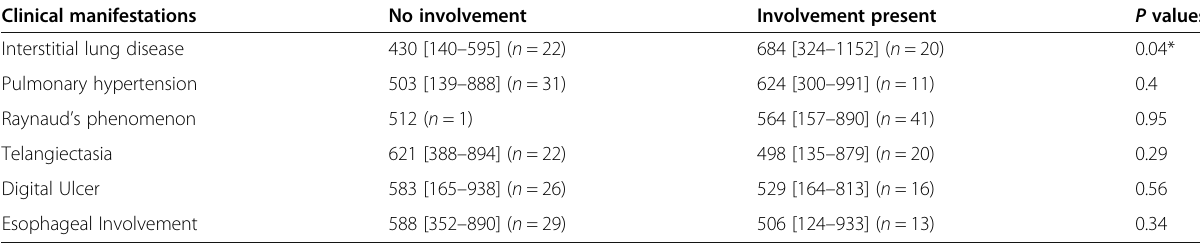
Table 2 Alpha defensin levels according to clinical manifestations of systemic sclerosis Clinical